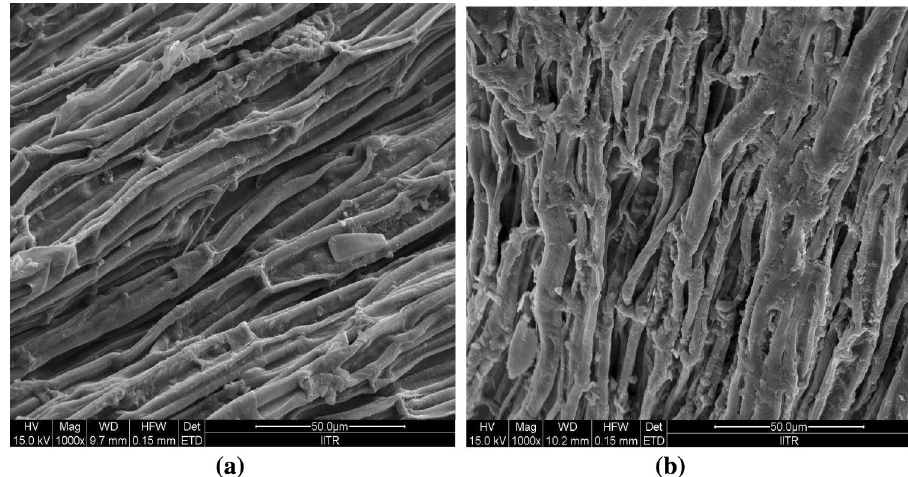
Fig. 4 a SEM analysis of Eich- hornia crassipes roots unloaded with phenol and cyanide and b loaded with phenol and cyanide (at a magnification of 1 K)